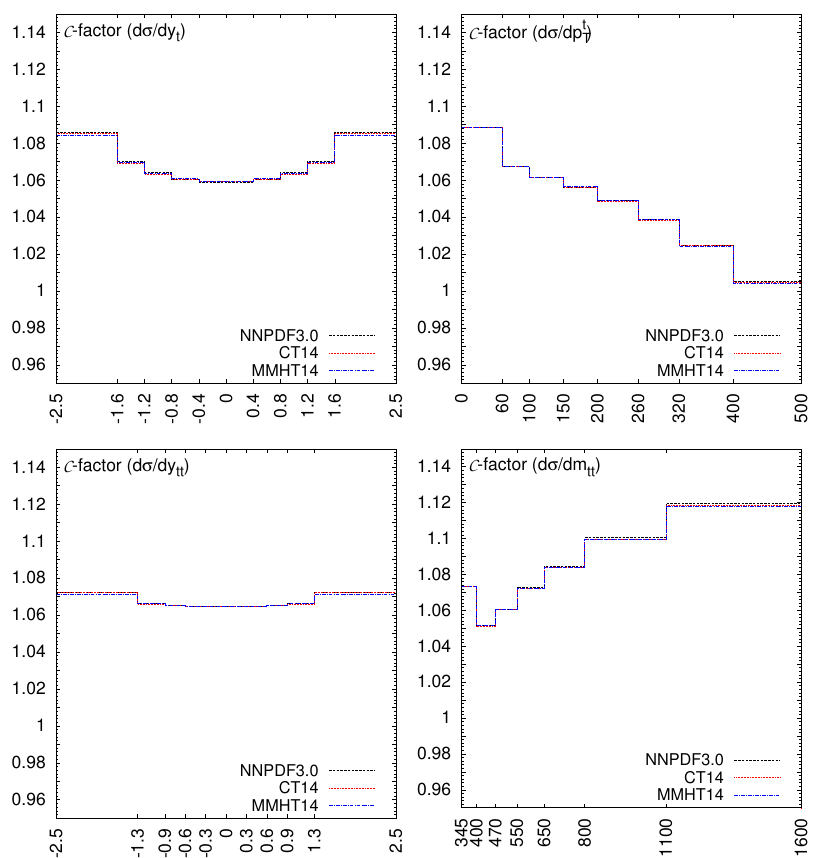
Figure 1 . The C -factors eq. (3.3) for the four absolute di(cid:11)erential distributions of table 1. where (cid:27) nnlo ( (cid:27) nlo ) is the partonic cross-section computed with NNLO (NLO) matrix ele- e e ments and L nnlo is the corresponding parton luminosity evaluated with a reference set of NNLO PDFs. The numerator and the denominator in eq. (3.3) were computed with the code of